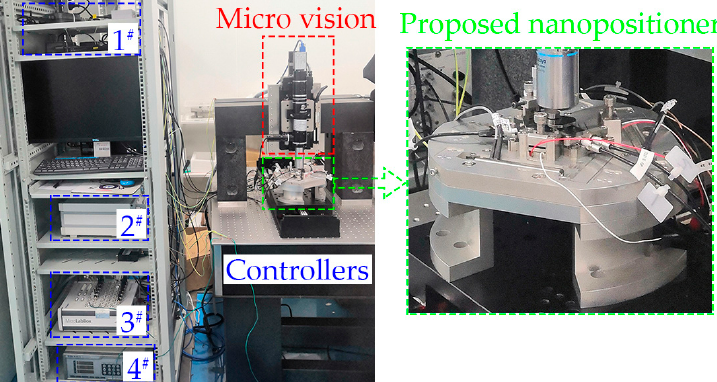
Figure 3. Prototype setup of the proposed nanopositioner, micro-vision system, and controllers.